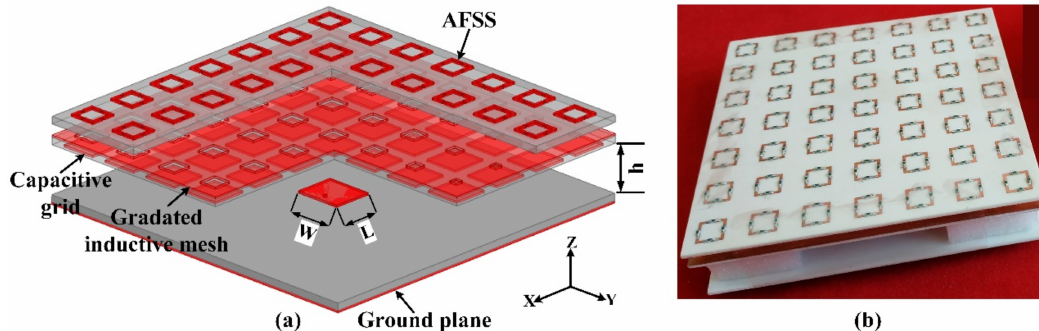
Figure 4. Proposed antenna. ( a ) Simulated model (cutout view). ( b ) Fabricated prototype. (h = 13 mm, L = 12 mm, W = 14